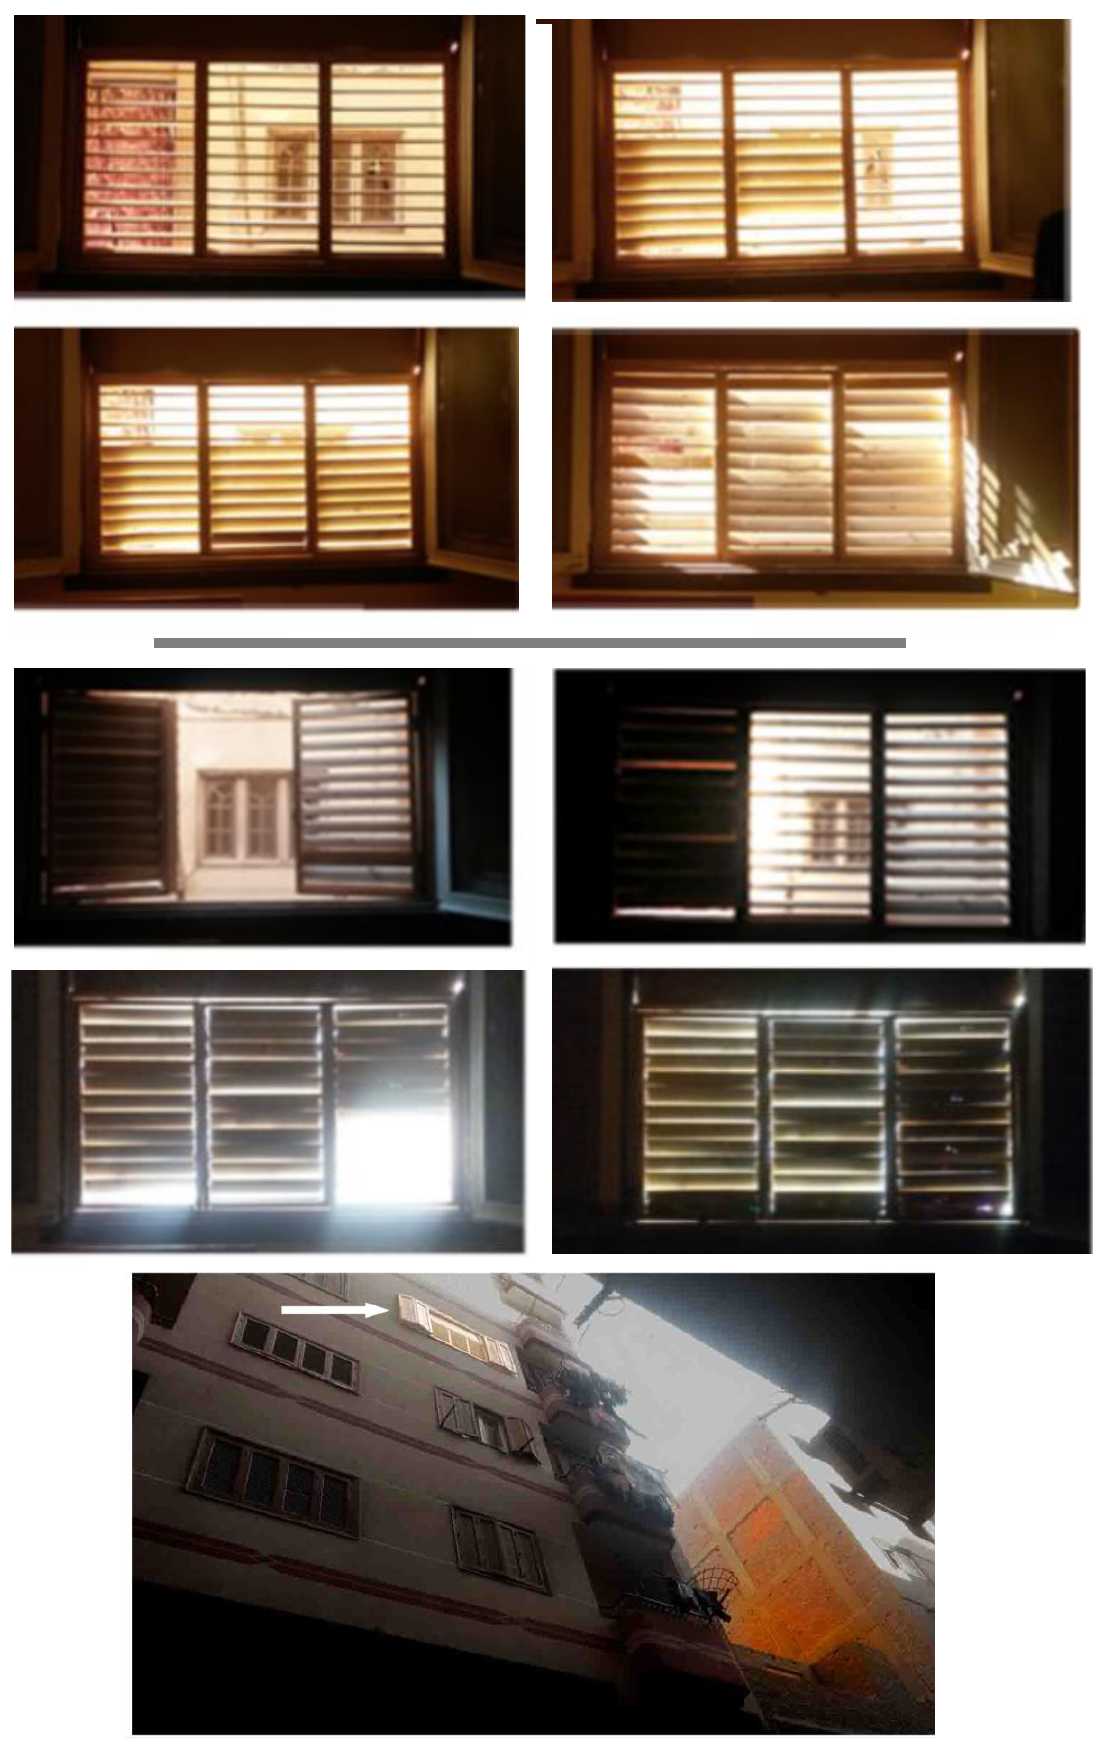
Figure 8. Photos of the MS installation onsite (Author,2017). The top 4 photos show the effect of direct lighting on the experiment room and the bottom 4 photos show the effect natural lighting on the experiment room. The bottom photo shows the MS from the outside of the building with the conventional shutters left wide